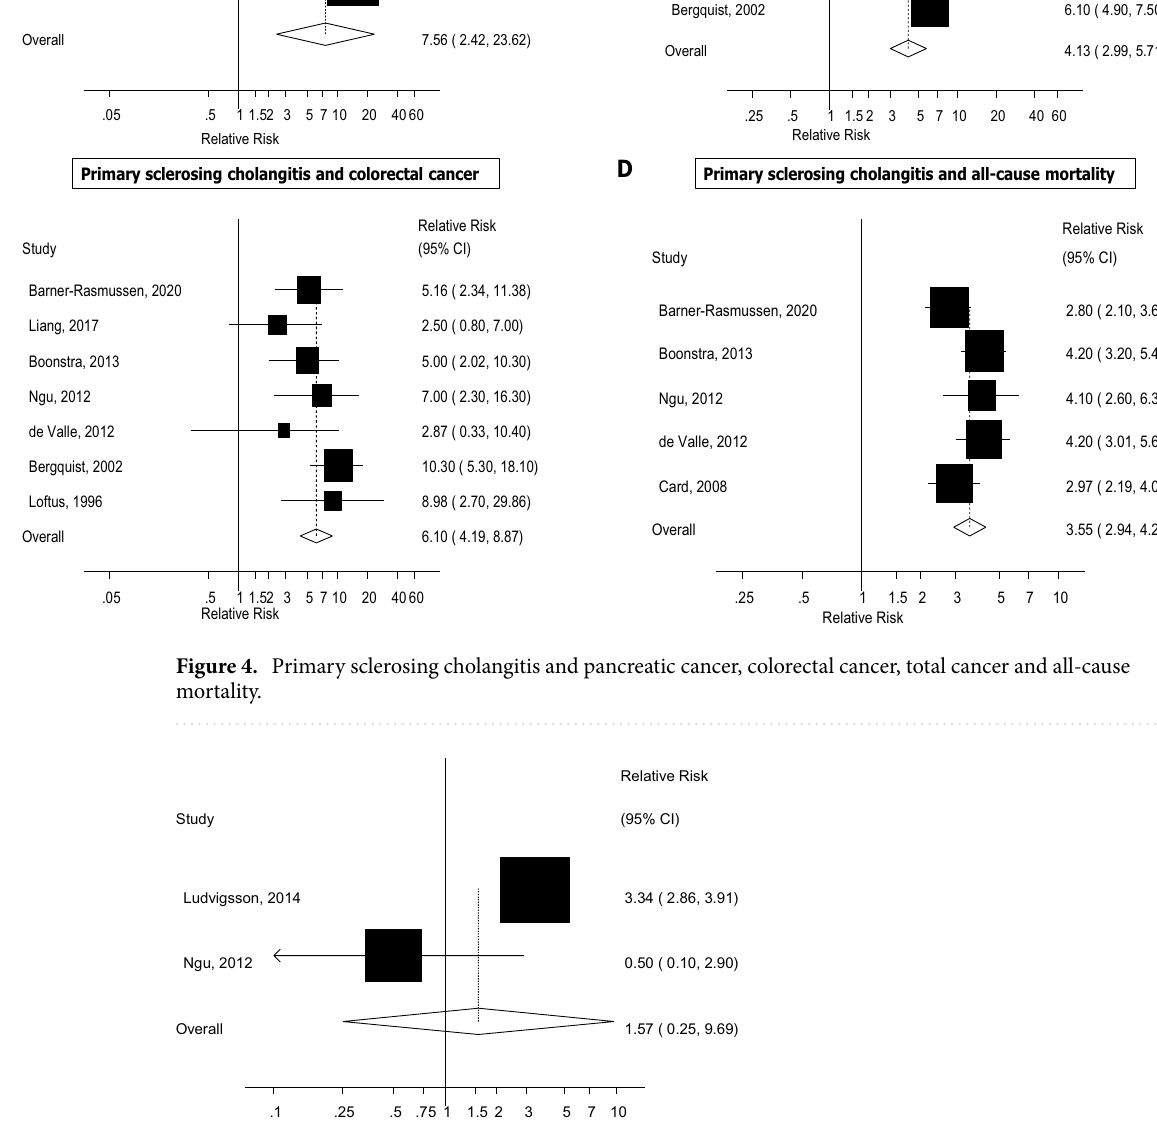
Risk.1 .25 Relative Figure 5. Primary sclerosing cholangitis and cardiovascular